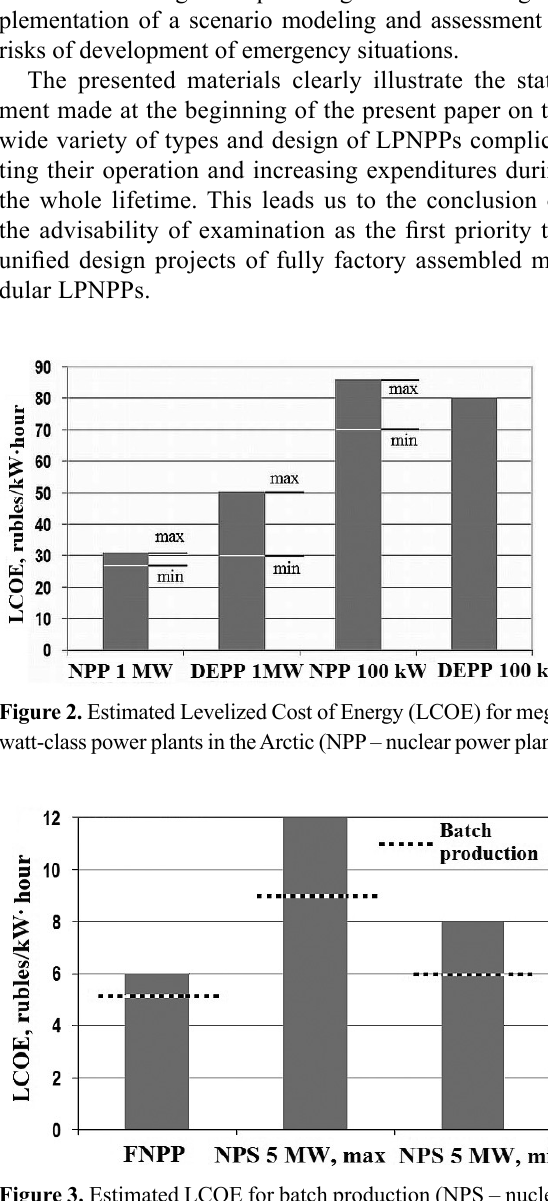
Figure 3. Estimated LCOE for batch production (NPS – nuclear power